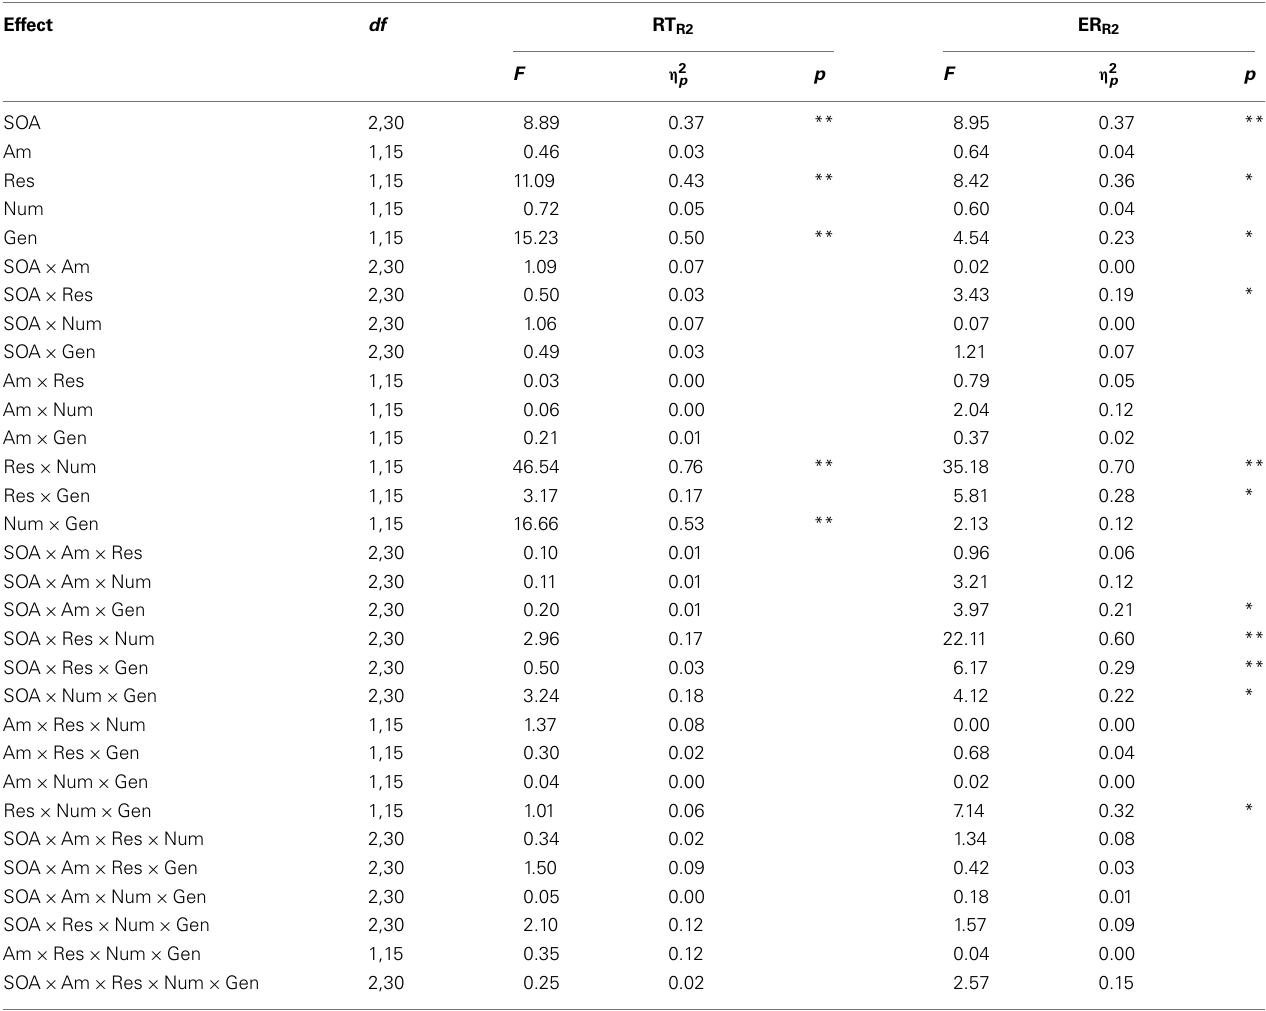
TableA2 | Results of analysis of variance on mean reaction times of correct responses (RT) and error rates (ER) for Experiment